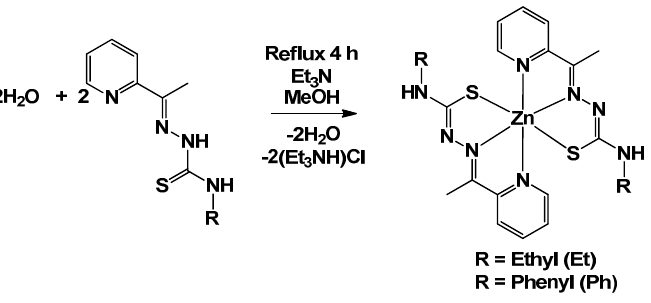
Scheme 1. Synthesis of the complexes.